Question: Summarize what this figure shows in one sentence.
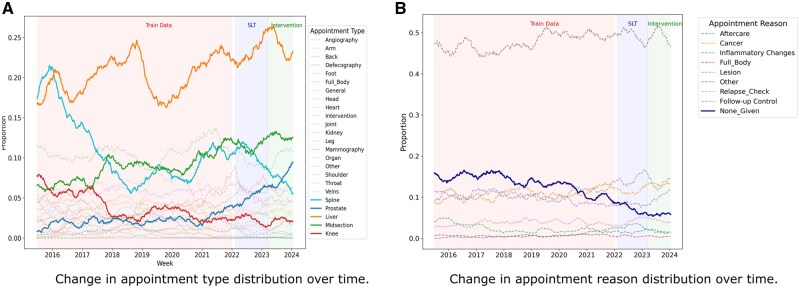
Answer: Shifts in appointment data distributions over time, illustrating data drift between training and deployment periods. (A) Change in appointment type distribution over time. (B) Change in appointment reason distribution over time.